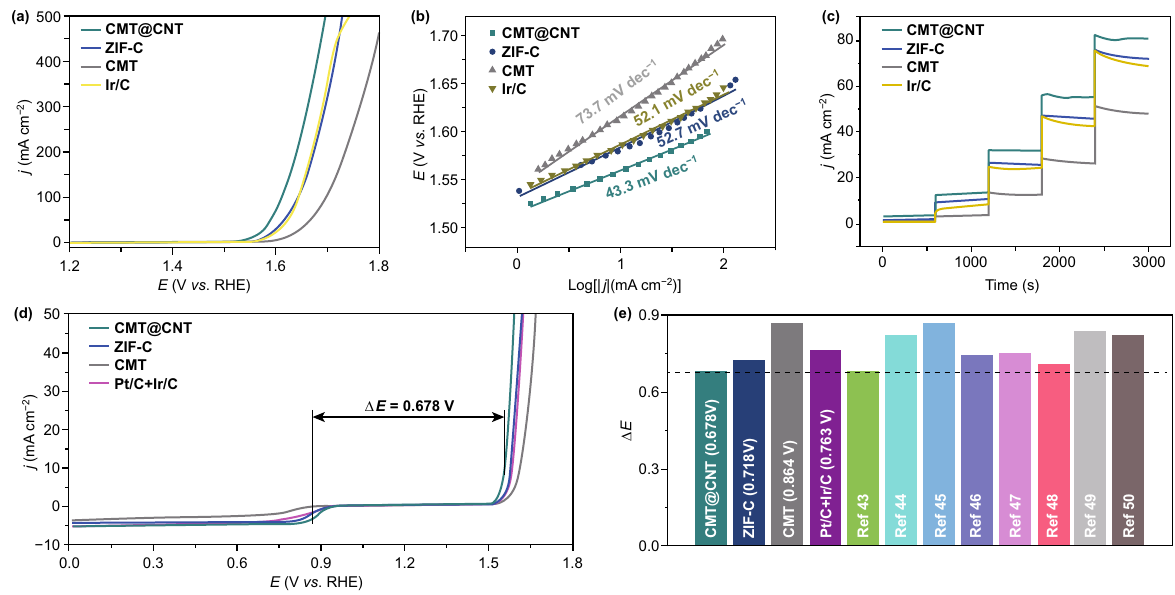
Fig. 4 OER performance of CMT@CNT, ZIF-C, CMT, and Ir/C. a LSV curves, b Tafel slopes, and c multi-potential steps curves. d Overall LSV curves and e Δ E of CMT@CNT, ZIF-C, CMT, Pt/C + Ir/C, and the